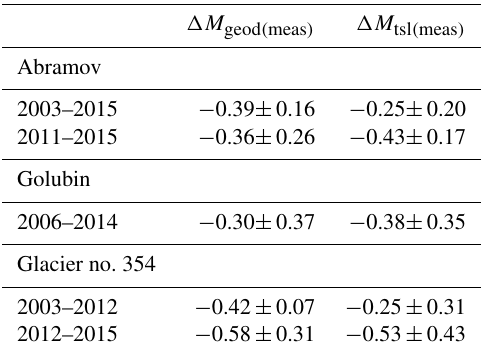
Table 8. Geodetic mass change (cid:49)M geod ( meas ) and the total annual mass change derived from the snow line approach (cid:49)M tsl ( meas ) for the three glaciers and for the periods corresponding to the geodetic surveys in mw.e.yr − 1